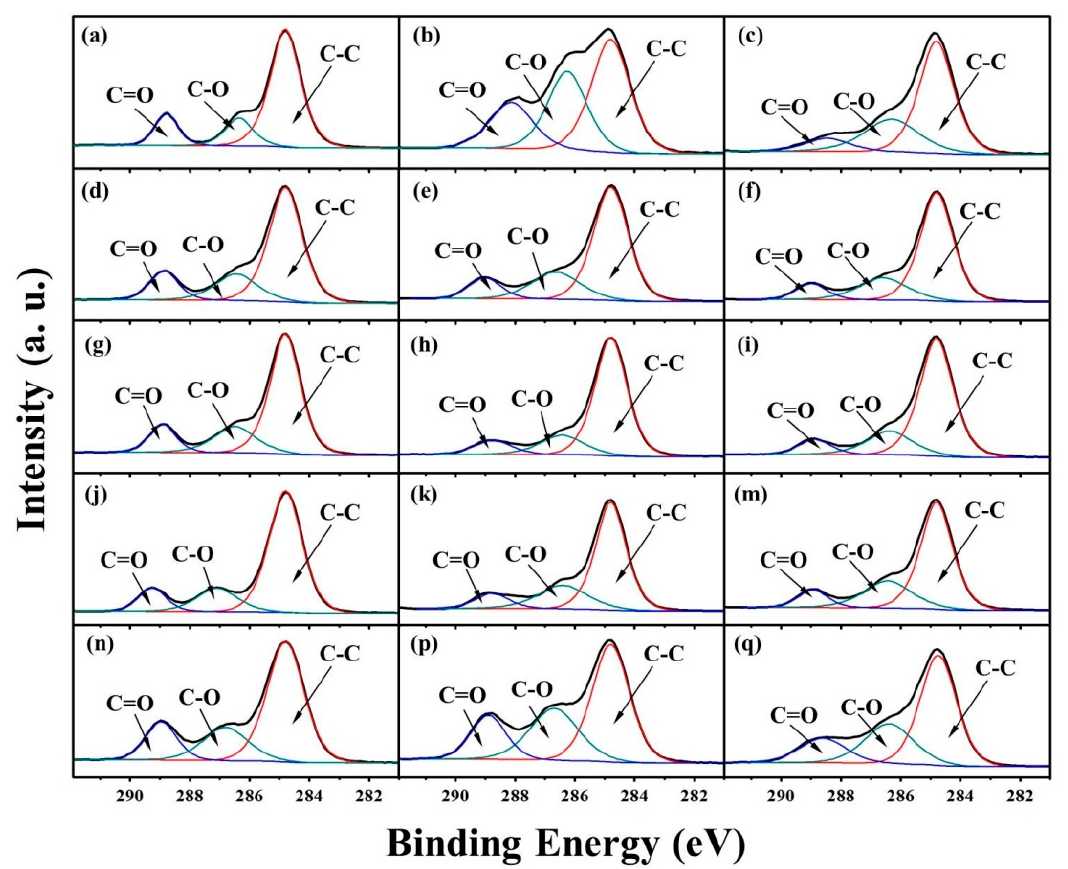
Figure 6. XPS C1s core-level spectra of ( a – c ) PBAT, ( d – f ) PLA / PBAT-25, ( g – i ) PLA / PBAT-50, ( j , k , m ) PLA / PBAT-75 and ( n , p , q ) PLA before and after degradation for 12 and 24 months.